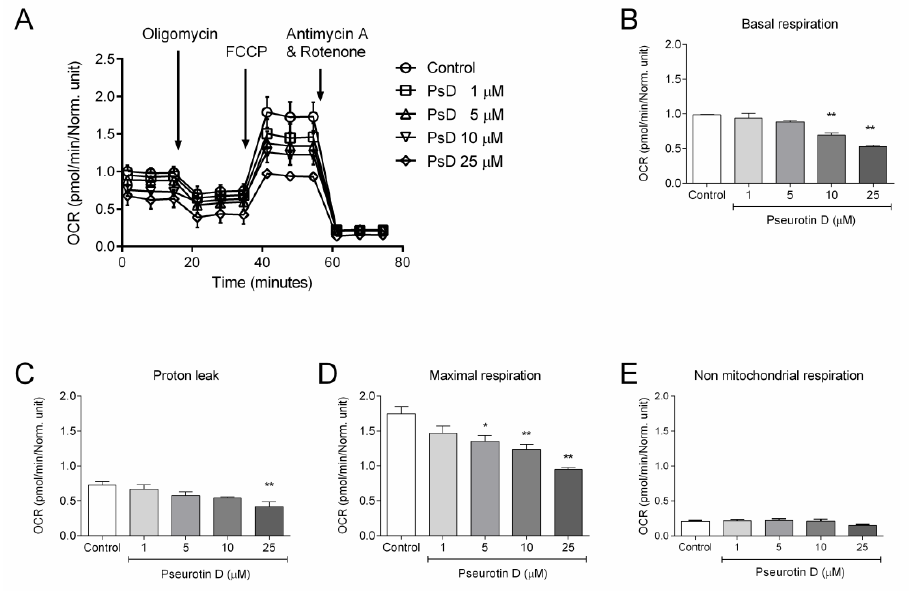
Figure 4. The effect of pseurotin D (1–25 µ M) on MEC-1 metabolic activity. Cells were incubated with pseurotin D for 24 h and subsequently assessed with respect to their oxygen consumption rate (OCR). For induction of metabolic stress 1.0 µ M oligomycin, 1.5 µ M FCCP, 0.5 µ M Antimycin A, and 0.5 µ M Rotenone were used. Curves of OCR kinetics are shown in ( A ). Basal respiration ( B ), proton leak ( C ), maximal respiration ( D ), and non-mitochondrial respiration ( E ) were calculated from